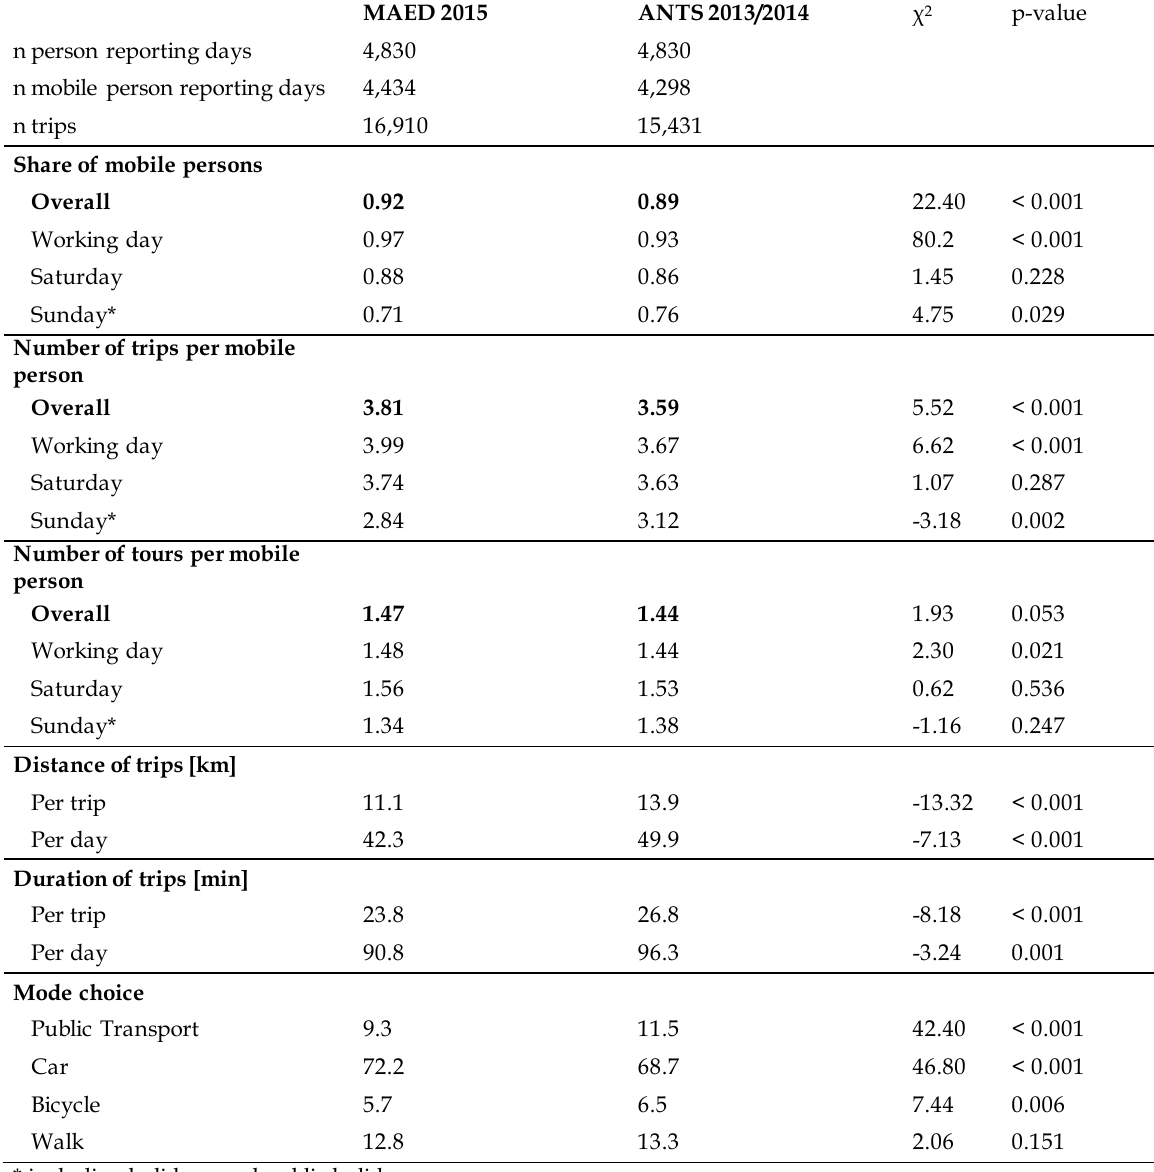
Table 2. Travel estimates for MAED and ANTS (matched